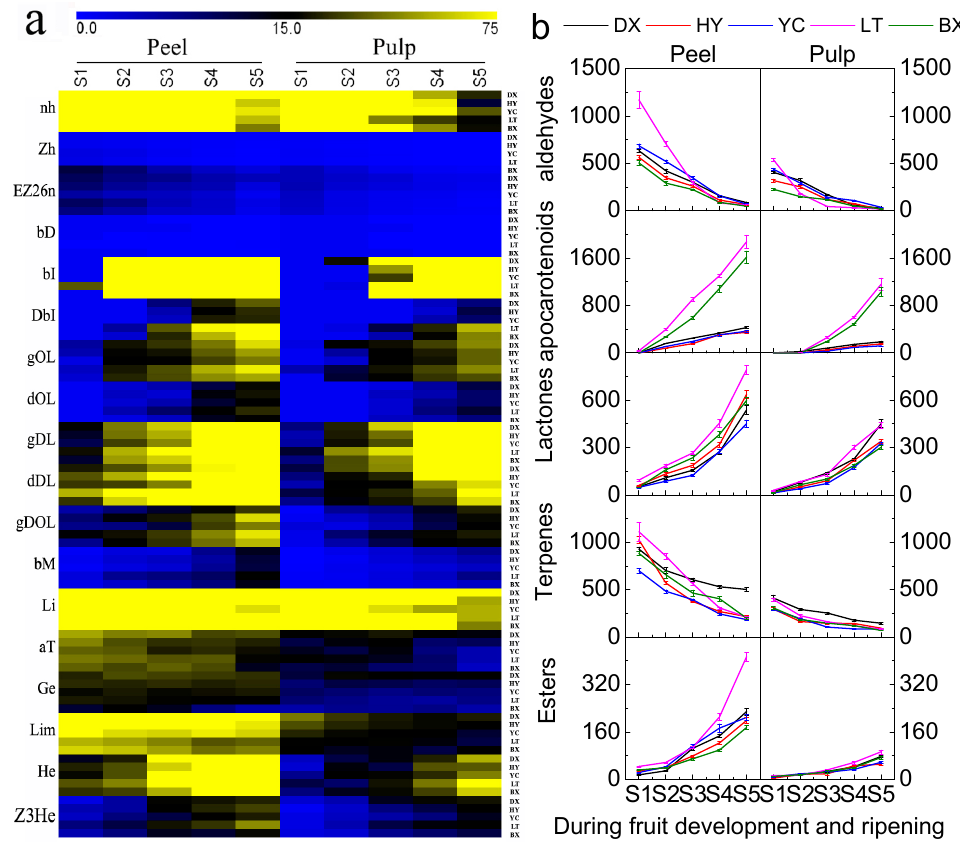
Figure 5. Volatile compound contents ( μ g/kg FW) in apricot fruit during development and ripening. ( a ) The left letters represent the aroma compounds in Table 2, the right double capital letters represent the cultivars in Table 1; ( b ) Total contents of each type of aroma compound during fruit development and ripening. The top double capital letters present the cultivars in Table 1. All data are expressed as means ± standard error of triplicate samples.